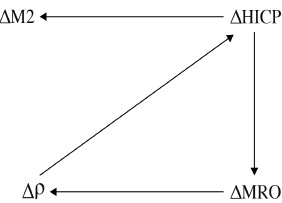
Figure 4. Granger casual relationship between ˆ ρ t and monetary